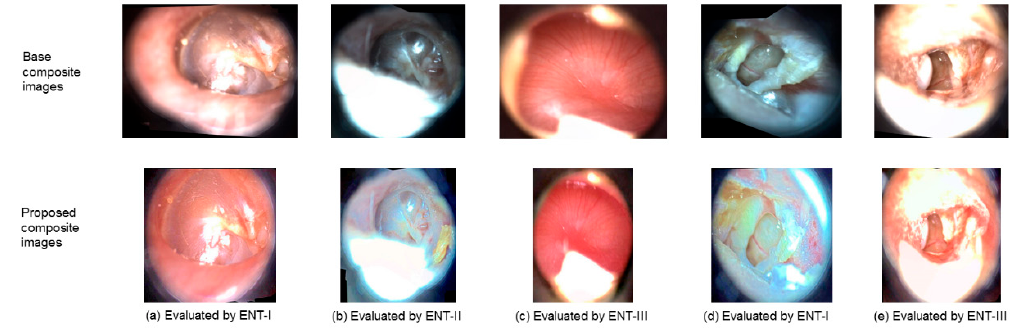
Figure 9. Exemplary composite images for the cases where the results deteriorated after SelectStitch. The first row shows the images generated by the base processes and the second row shows the images by SelectStitch. In all cases, the readers gave a score of 3 for base process composite image and 2 for the SelectStitch composite image.